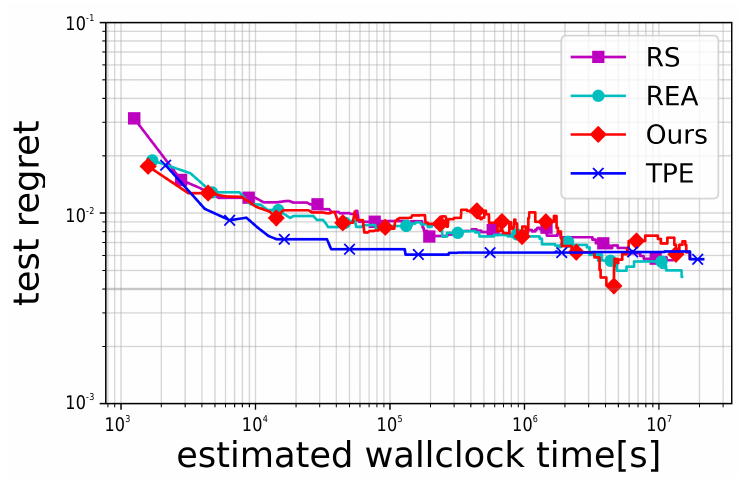
Figure 8. Search trajectories of Random search, REA and QDO on NAS-Bench-1Shot1.